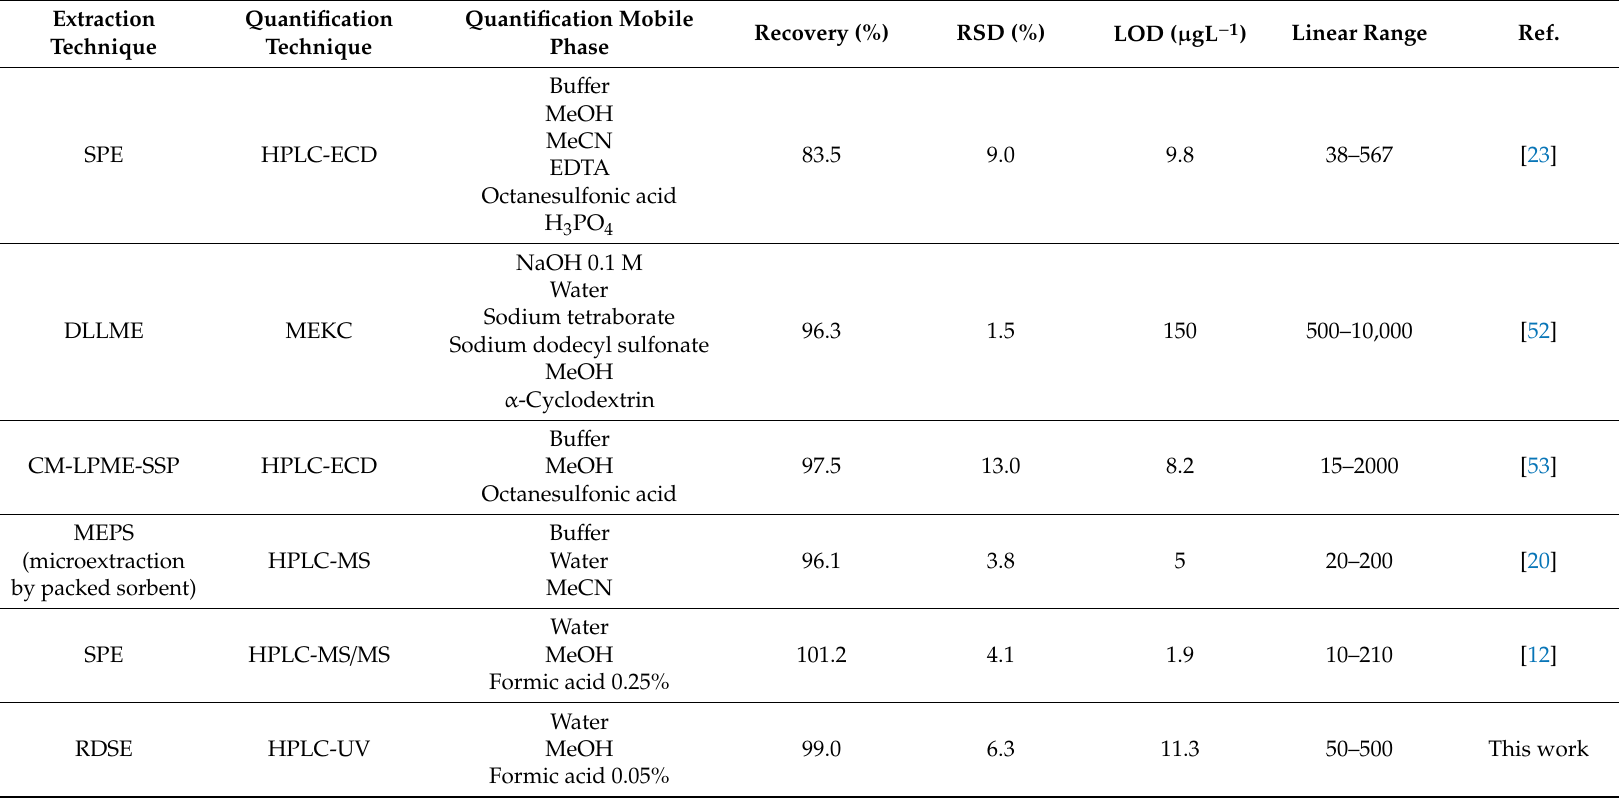
Table 4. Comparison of the RDSE microextraction method with other published methods for